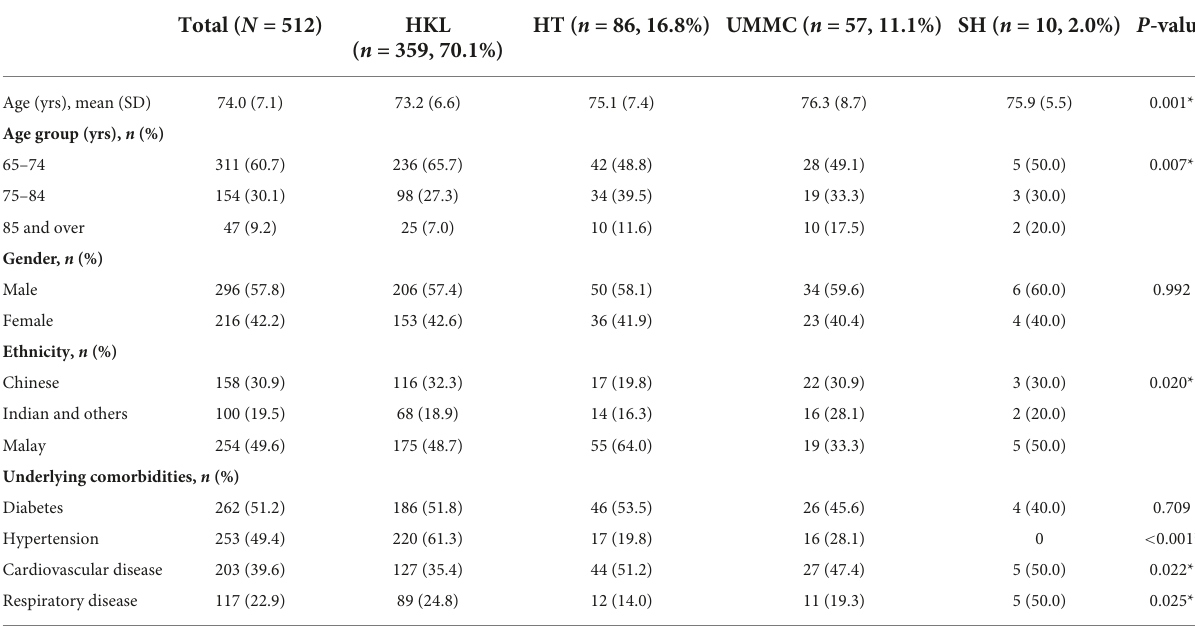
TABLE 1 Basic characteristics of participants.